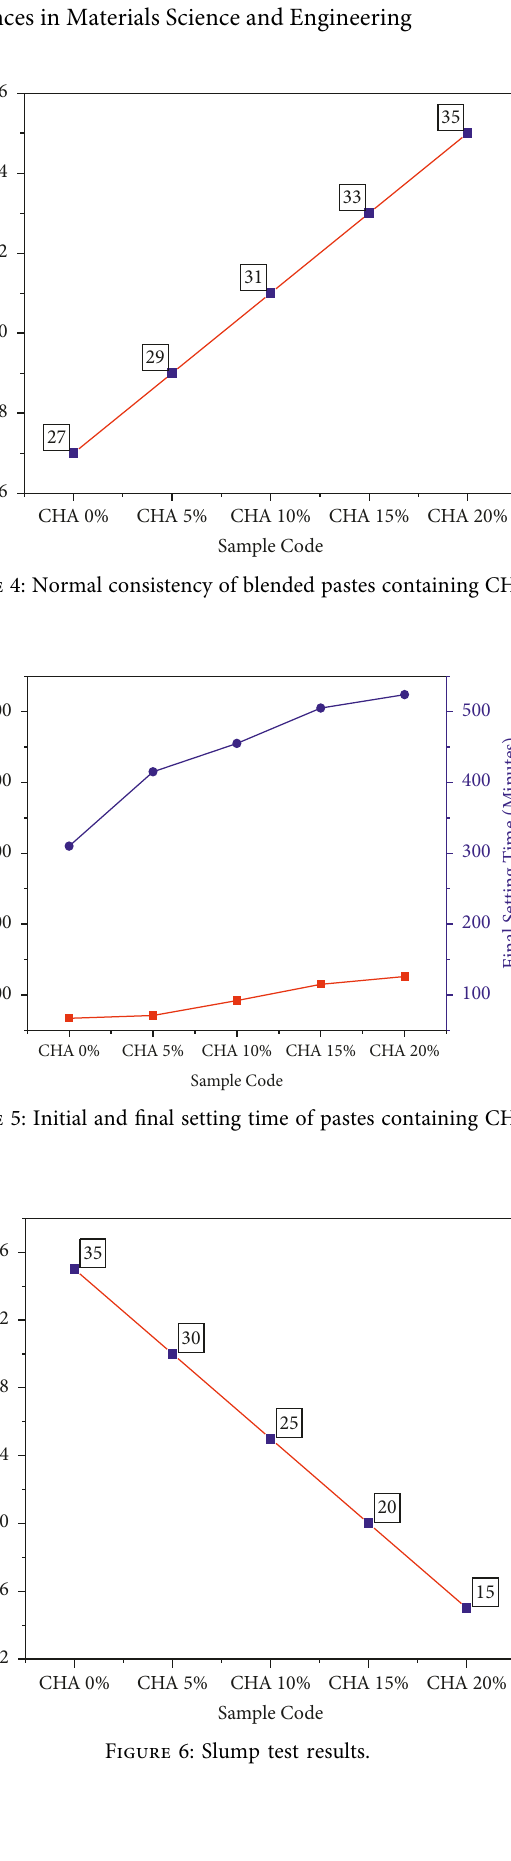
Figure 6: Slump test results.